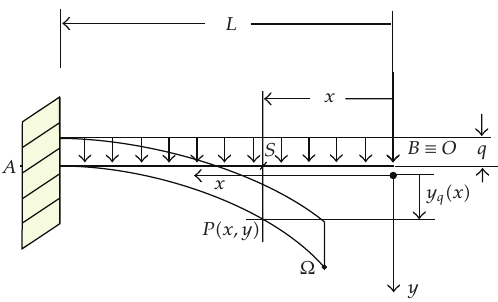
Figure 2: Horizontal cantilever rod bent by a uniform